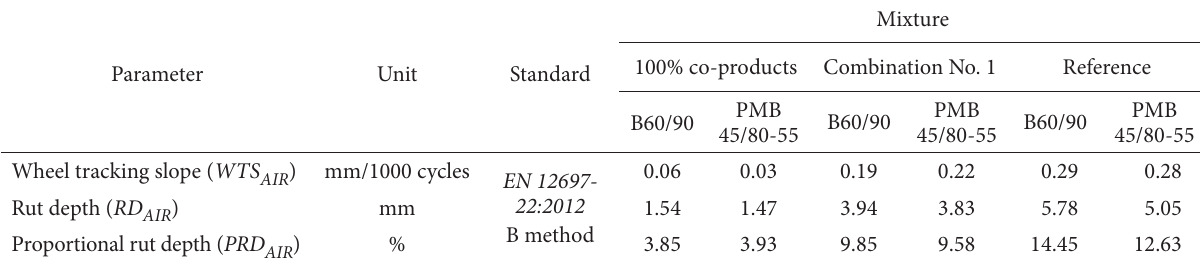
table 7. Numerical values of Wheel Tracking Test